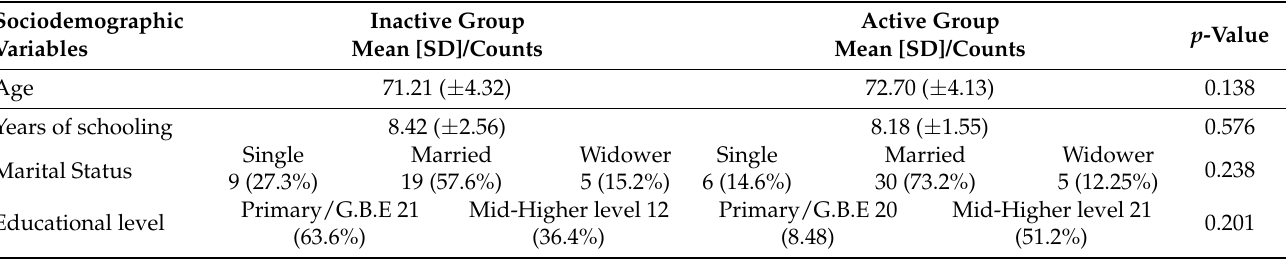
Table 1. Sociodemographic variables.